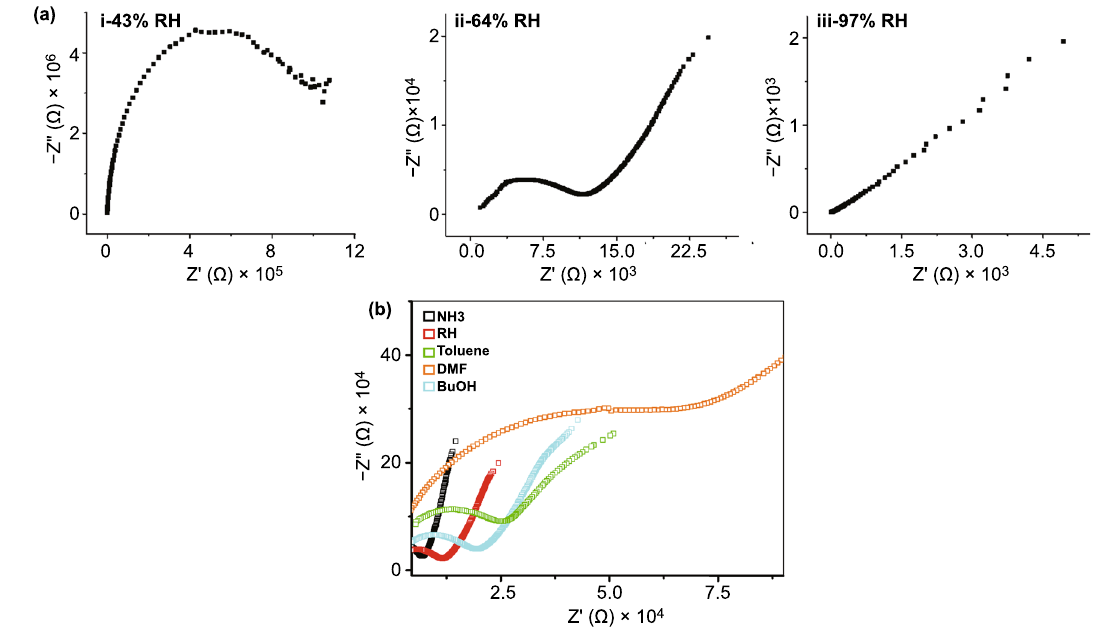
Fig. 3 Impedance spectroscopy of the carbon‑dot‑IDEs upon exposure to different vapors. a Nyquist plots of the orange C‑dot‑IDE recorded in the indicated relative humidity (RH) levels. b Nyquist plots of the orange C‑dot‑IDE recorded following exposure to different gas molecules (RH was 64%; concentrations of gas molecules were all 35 ppmv). (Color figure